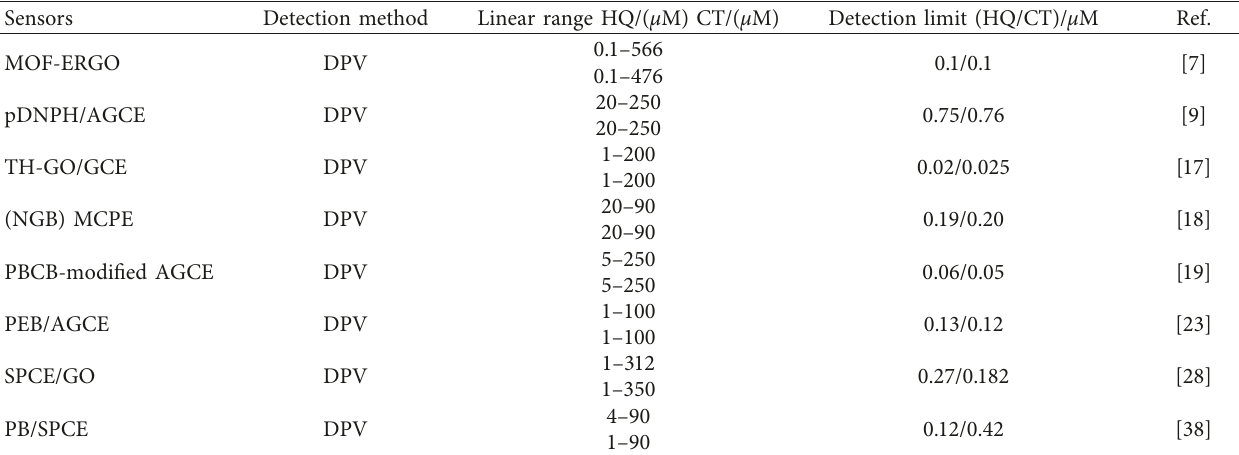
Figure 7: DPV responses at PCH/AGCE in PBS (pH 7.0) containing (a) 50 μ M of CTand different concentrations of HQ ( a ⟶ j : 0, 1, 5, 10, 20, 30, 40, 60, 80, 100, 200, and 300 μ M); (b) 50 μ M of HQ and different concentrations of CT ( a ⟶ j : 0, 1, 5, 10, 20, 30, 40, 60, 80, 100, 200, and 300 μ M); (c) mixture of different concentrations of HQ and CT ( a ⟶ j : 0, 1, 5, 10, 20, 30, 40, 60, 80, 100, 200, and 300 μ M). Inset: plots of I pa as a function of [HQ] or [CT]. Table 1: Analytical performance of sensors reported in the literature for the detection of HQ and CT.